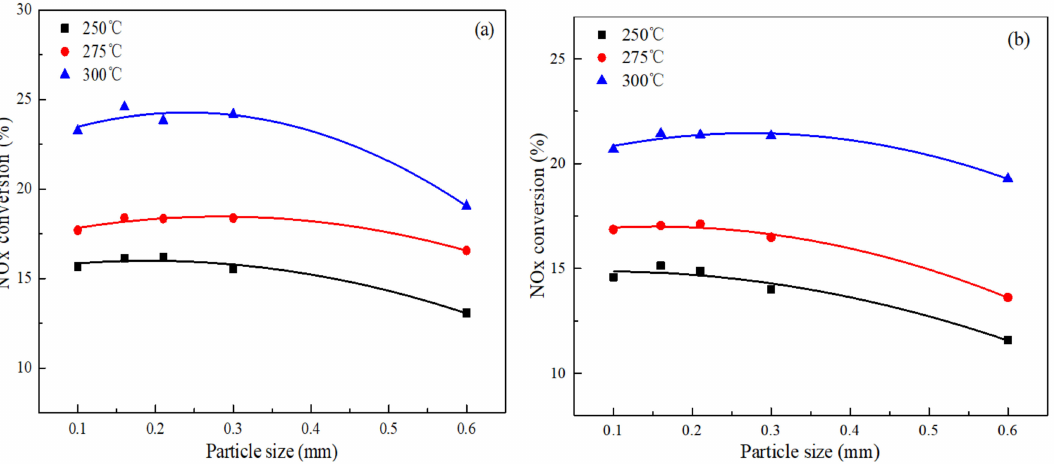
Figure 2. Effect of particle size on NO x conversion over the SOC and SSOC-5 ( a ) SOC, W/F = 0.9 kg · s · L − 1 , ( b ) SSOC-5, W/F = 0.36 kg · s · L − 1